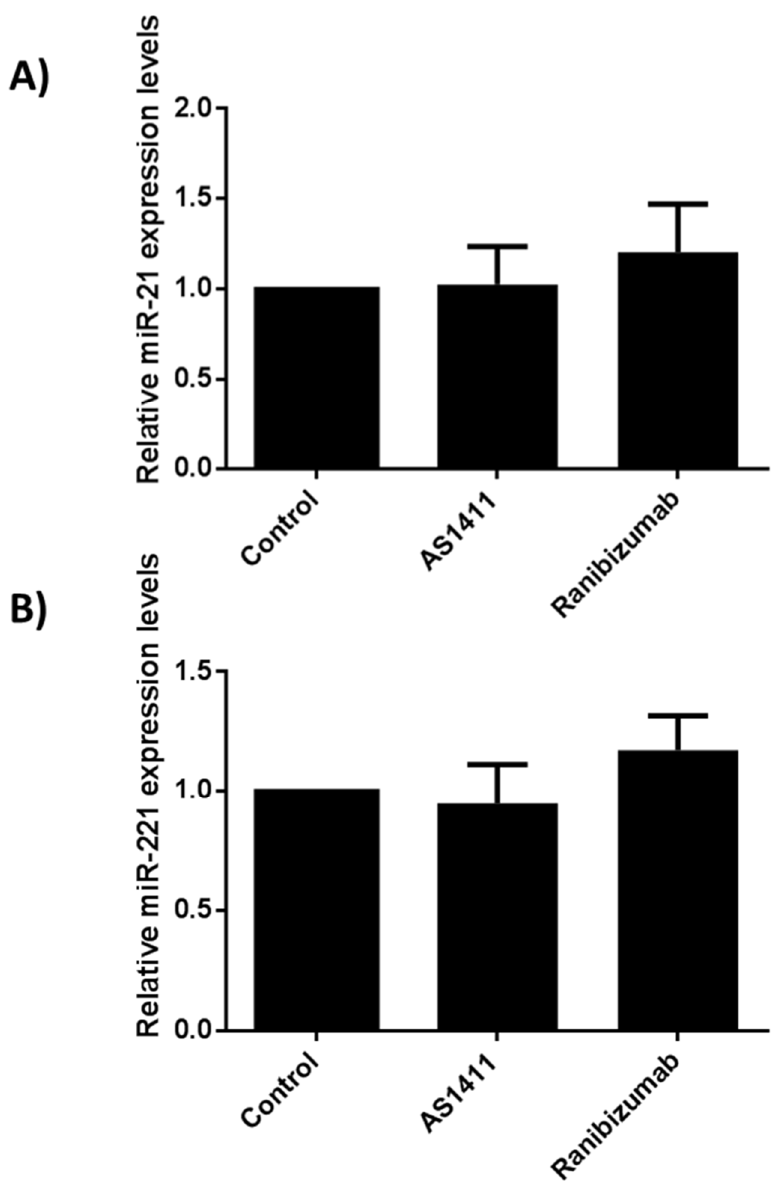
Figure 7. AS14111 aptamer treatment does not affect miR-21 and -221 relative expression levels in HUVEC. ( A ) AS1411 aptamer and ranibizumab failed to reduced miR21 relative expression levels in cultured HUVEC. ( B ) AS1411 aptamer and ranibizumab failed to reduced miR-221 relative expression levels in cultured HUVEC. The bars represent the mean (±SE) of three independent assays.